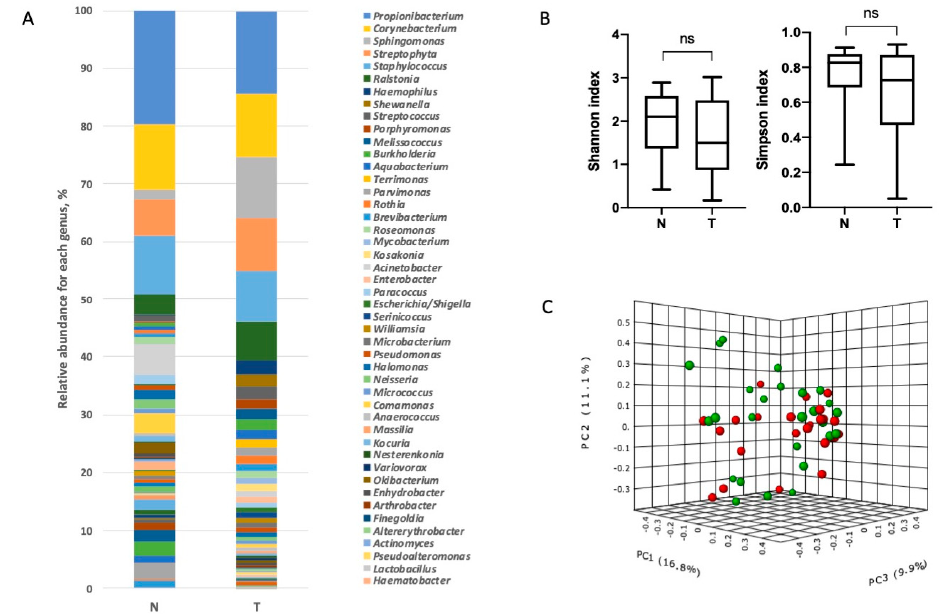
Figure 2. Taxonomic composition of the microbial community of lung tissues on the level of genera. ( A ). Characterization of NSCLC microbiota. Relative abundance at the genus level for tumor and normal tissue samples. ( B ). Taxonomic α -diversity calculated with the Shannon index and Simpson indices between N and T groups (ns - non significant). ( С ). PCoA plot based on the Bray–Curtis distance of the NSCLC microbiome between tumor and normal tissues (PERMANOVA) F-value: 1.2264; R-squared: 0.024913; p - value < 0.204 (green ball – tumor, red ball – normal tissue).